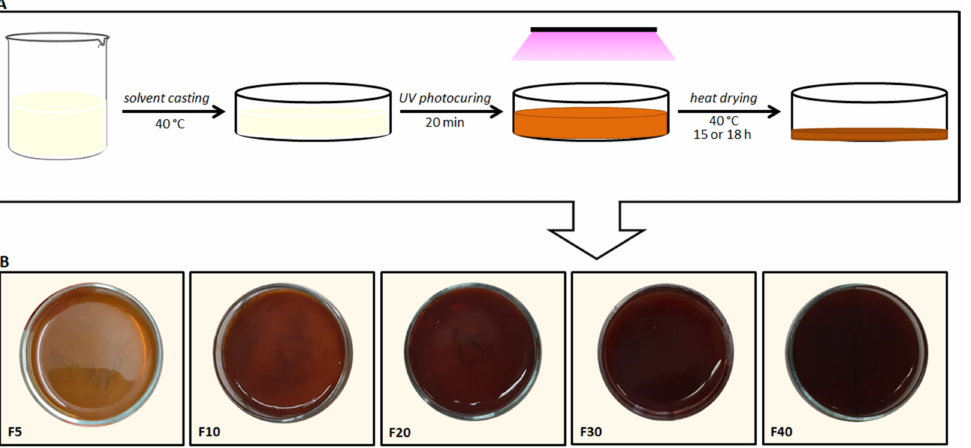
Figure 1. ( A ) Schematic of the procedure followed for the preparation of the nanocomposite films. ( B ) Images of the films obtained after the photocuring step.